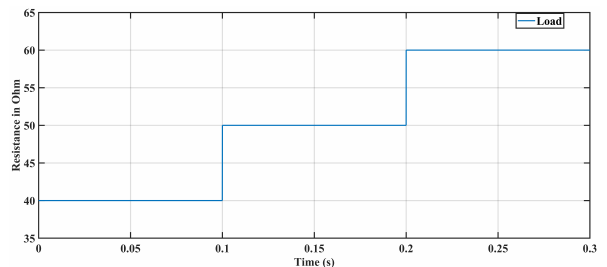
Figure 8. Variable resistive